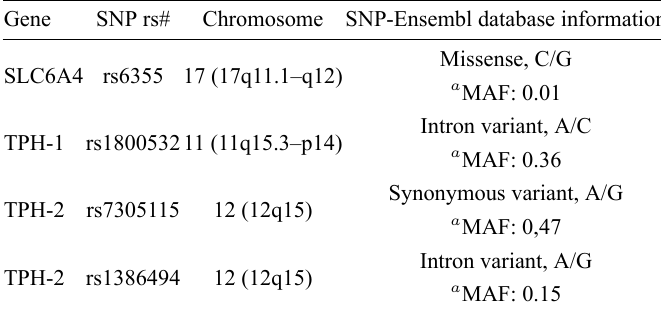
Table 1. Genes and polymorphisms included in the